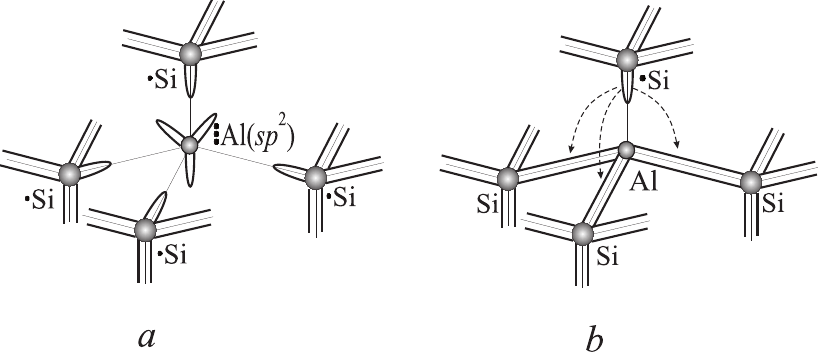
Figure 1. Radiation defect µ Al state in a silicon lattice: ( a ) all bonds with host atoms are broken in the initial state, and the defect state is determined by the “mixed” function 3 s 3 p 2 ; ( b ) three electrons of the impurity form chemical bonds with host atoms in the final state, and an unsaturated (broken) bond is equiprobable for four nearest neighbors of the cluster (AlSi 4 ) 0